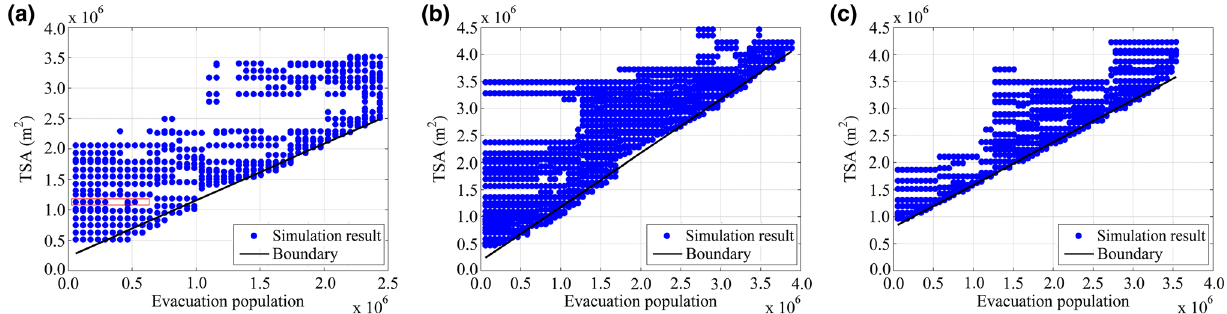
Fig. 13 Relationships between evacuation population and total shelter area (TSA) based on the joint relationships between popula- tion, total weighted evacuation time (TWET), and TSA. a – c Location